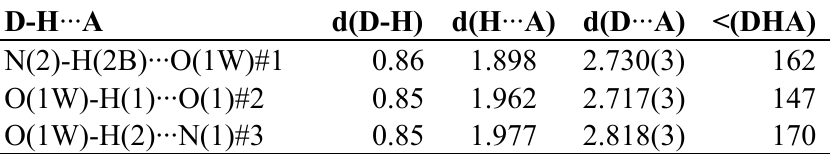
Table 2. Hydrogen bonds for compound (1) [Å and °].